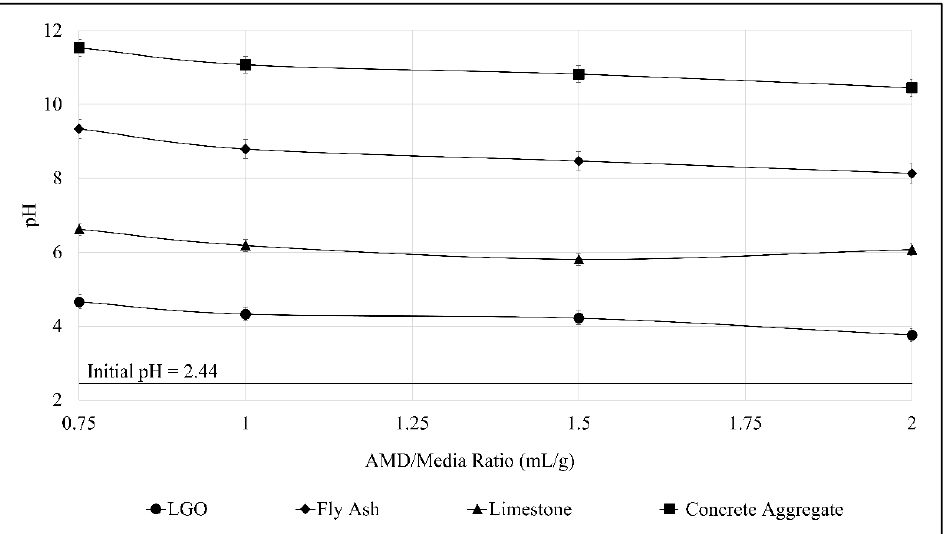
Figure 3. E ff ect of AMD / Media ratio on pH after 1-h mixing. Figure 3. Effect of AMD/Media ratio on pH after 1-h mixing.